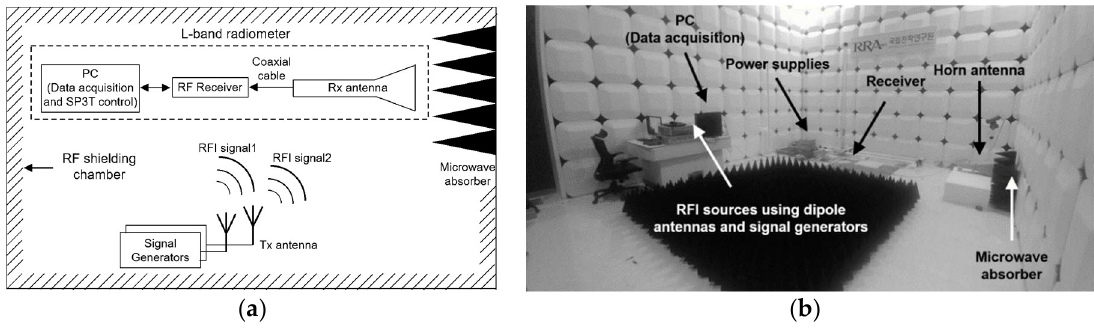
Figure 6. ( a ) Experimental setup; ( b ) photograph of the RFI test.